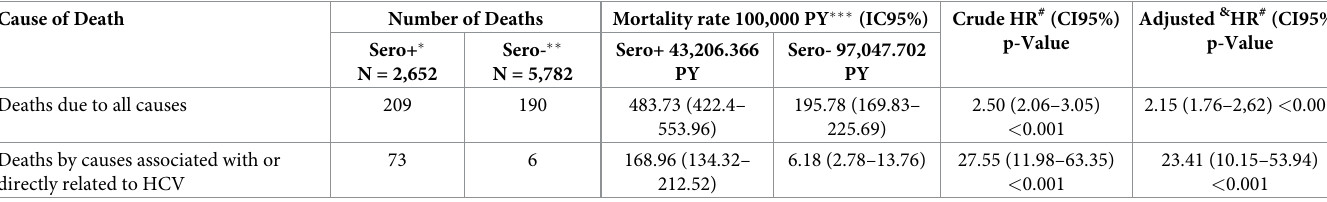
There were differences between seropositive and seronegative donors. Seronegative donors were younger, had a higher proportion of males and voluntary and repeated donors (Table 1).